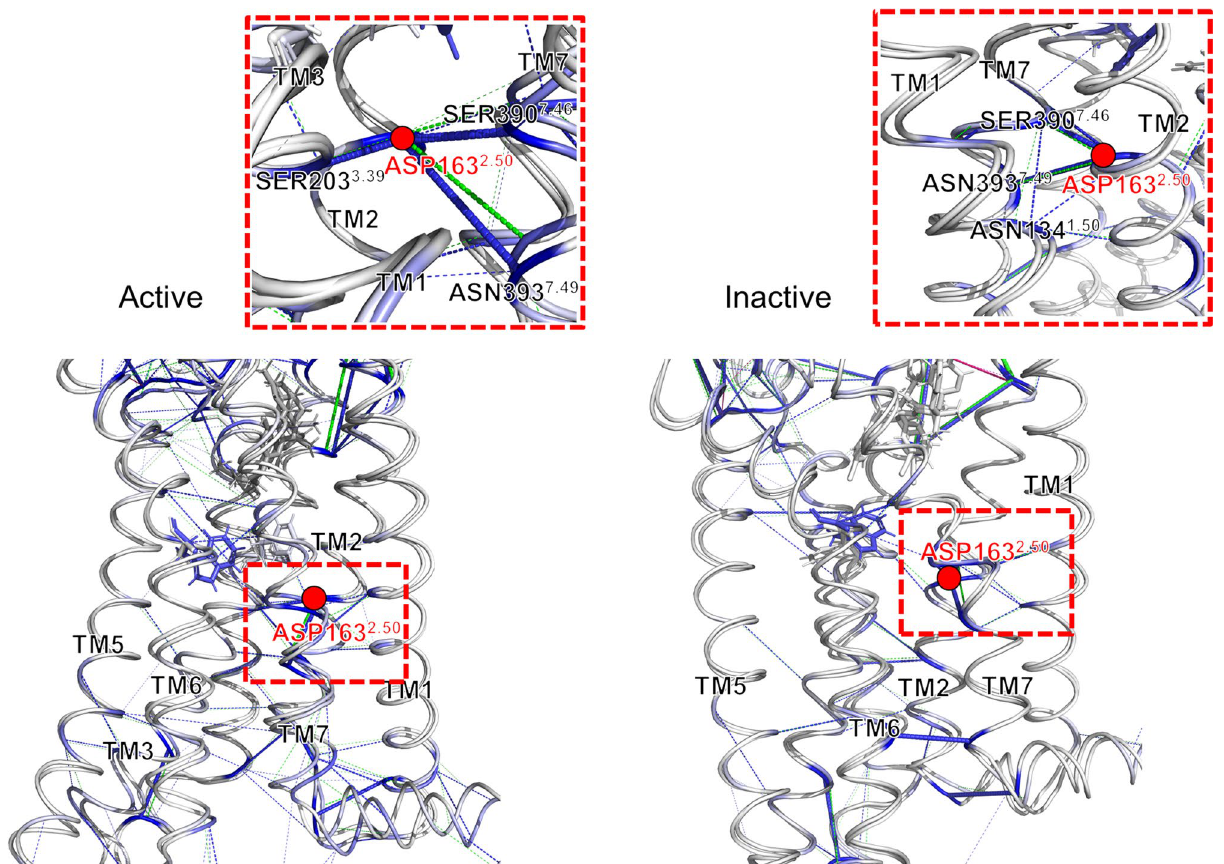
Figure 6. The hydrogen bond network of Na + pocket around D163 (D2.50). The residue pairwise interactions are visualized as bonds for wildtype (blue) and mutant (green) CB1. And each thickness of bond is the strength of pairwise interaction energy. The locations of D163 (D2.50) are marked as red circles. Especially, the hydrogen bond networks of Na + pocket in active and inactive CB1 are zoomed